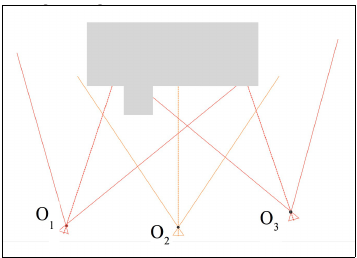
Figure 3. Rolleimetric system scheme (planimetric projection)